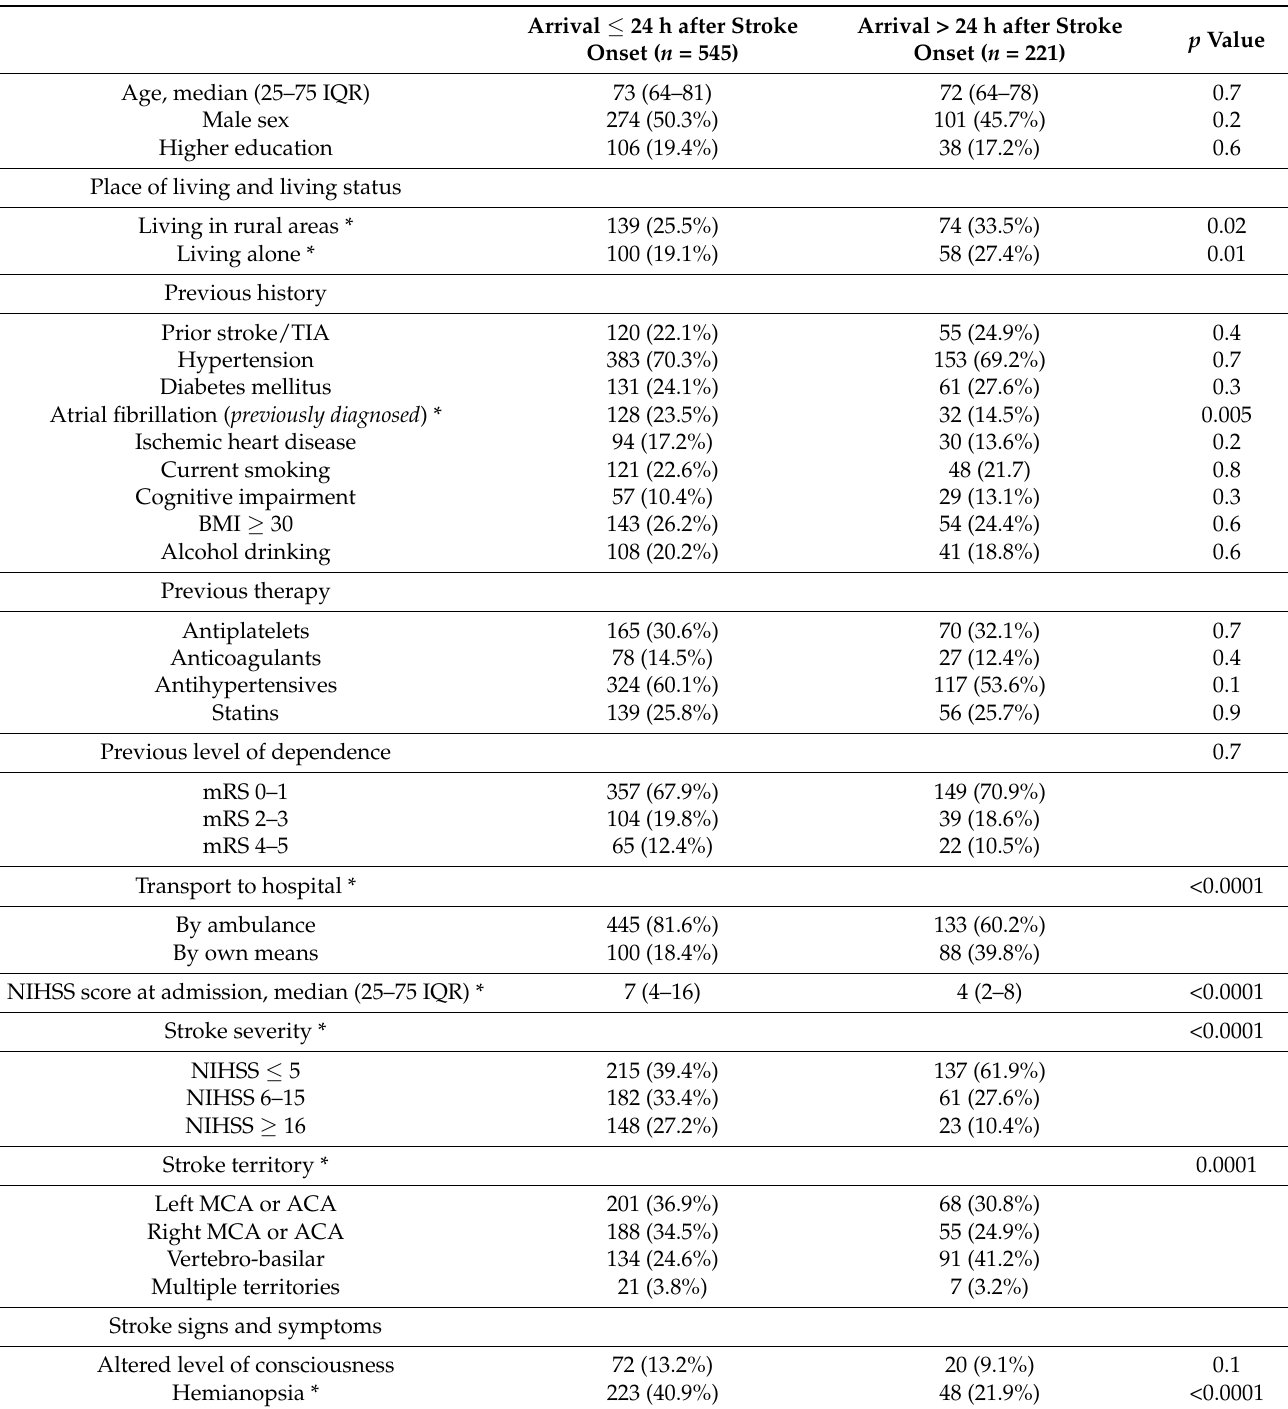
Table 3. Baseline characteristics of patients arriving at hospital before and after 24 h from stroke onset. Arrival ≤ 24 h after Stroke Arrival > 24 h after Onset ( n = 545)